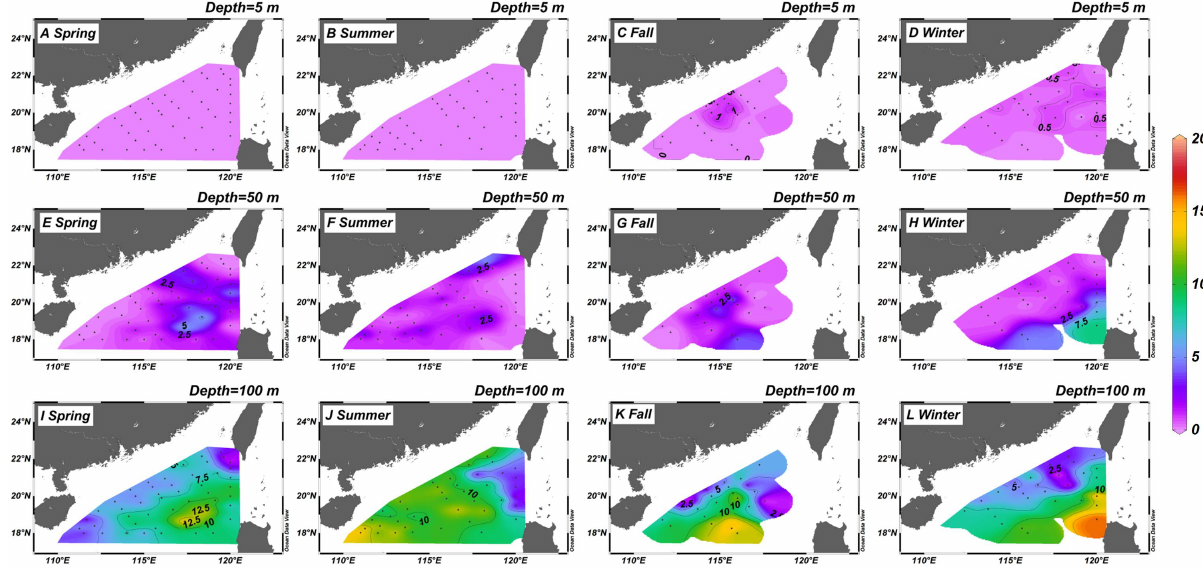
Fig. 3. Iso-depth distributions of N + N (nitrate plus nitrite,µmolL − 1 ) concentrations at depths of 5m (A–D) , 50m (E–H) and 100m (I–L) in the central northern South China Sea and Kuroshio during the four seasons (spring: A , E and I ; summer: B , F and J ; fall: C , J and K ; winter: D , H and L